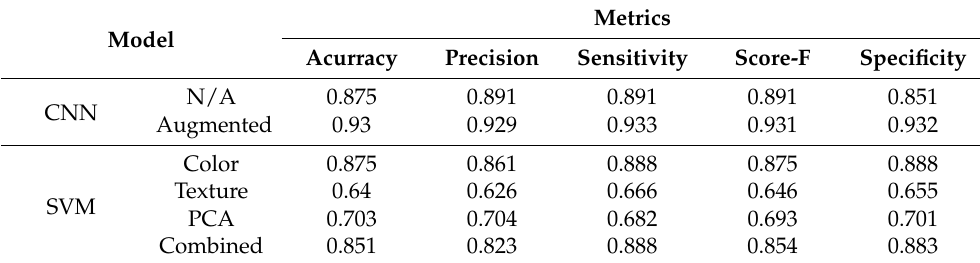
Table 3. Evaluation metrics from confusion matrices.